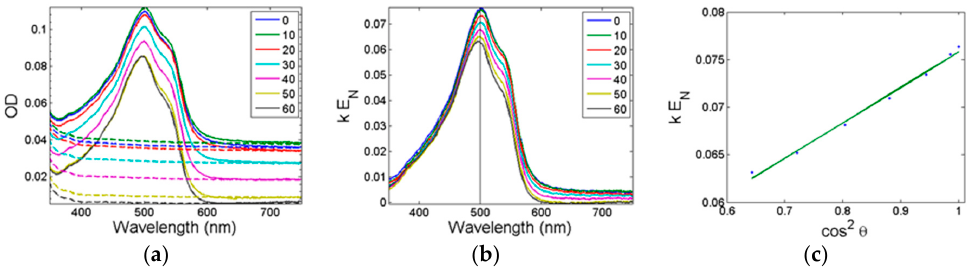
Figure 6. Data from polarized optical spectroscopy for Alura Red: BZK18 thin film. ( a ) Optical density (raw data) of the sample with nanostructures (full line) and the glass blank sample (dashed line). The legend shows the incident angle θ 1 from 0° to 60° in steps of 10°. ( b ) Absorption coefficient of the nanostructure E N times the constant k. Only the central wavelength marked with the straight vertical line is used for calculating α fZ,max . ( c ) Linear regression (red line) of experimentally determined kE N (black dots) against cos 2 θ 1 for the central wavelength.